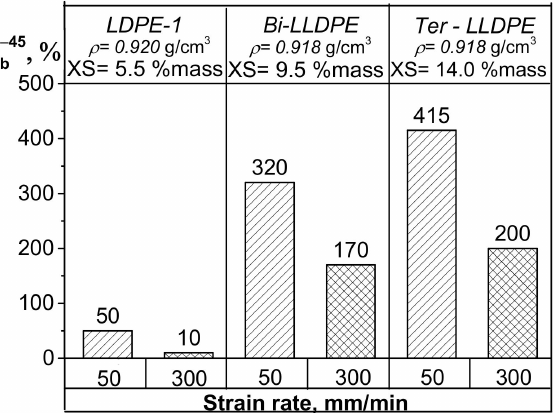
Figure 5. The data on ε − 45 for the LDPE, LLDPE-1, and LLDPE-2 samples at different strain rates (50 and 300